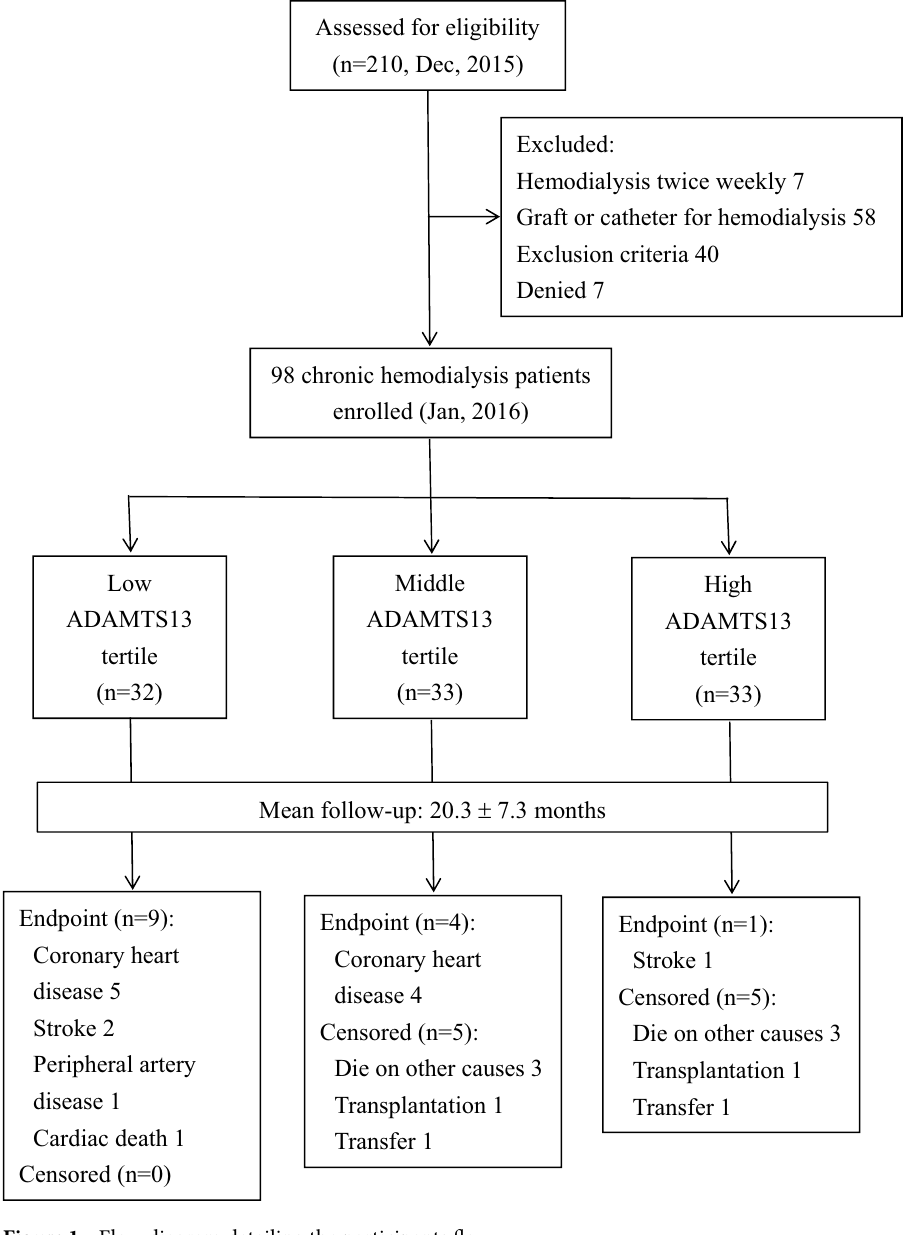
Figure 1. Flow diagram detailing the participants